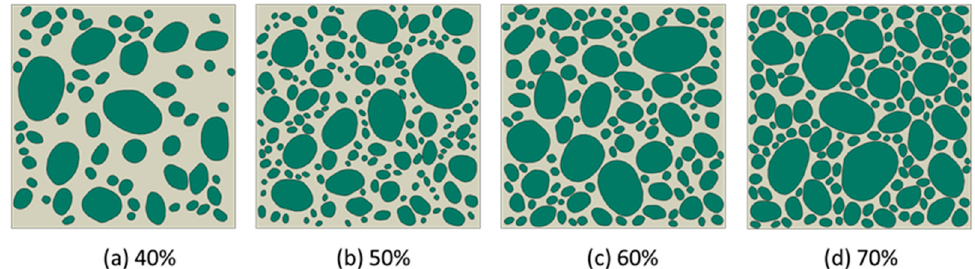
Figure 15. High-sphericity and well-rounded stone concrete models under different aggregate volume fractions, ( a ) 40%, ( b ) 50%, ( c ) 60%, and ( d ) 70%, respectively, with the scale factor between long and short axes, f = 1.